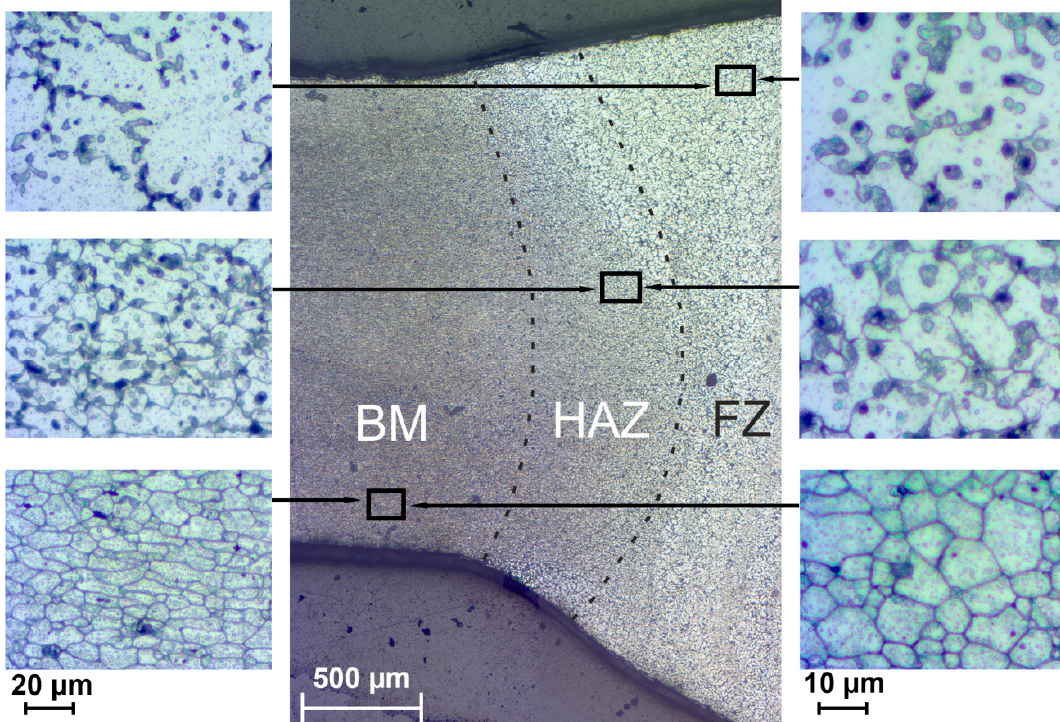
Figure 2. The microstructure of the TIG weld joint of the aluminum alloy including BM, HAZ, and FZ.